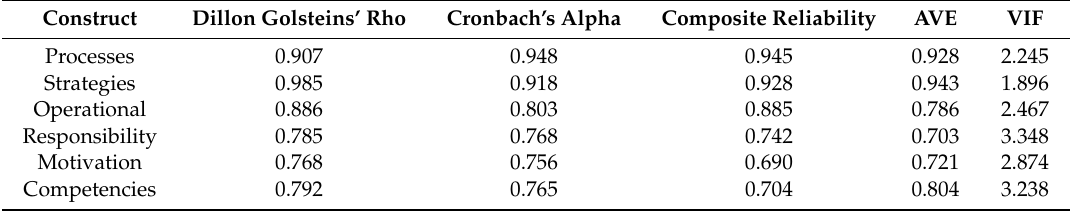
Table 5. Validity and reliability of the independent